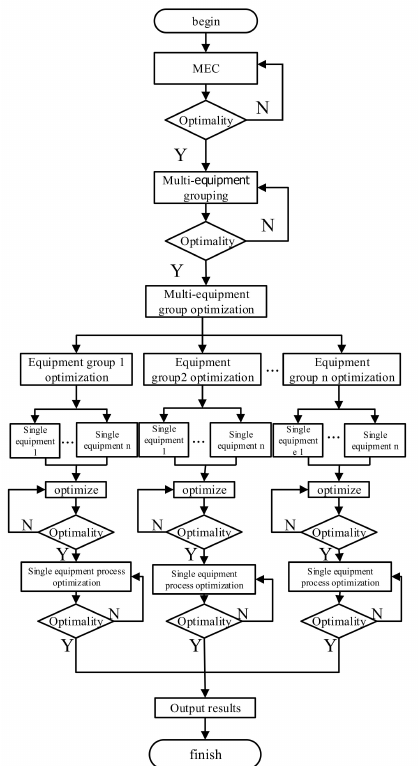
Figure 1. Flow chart for MEC operation